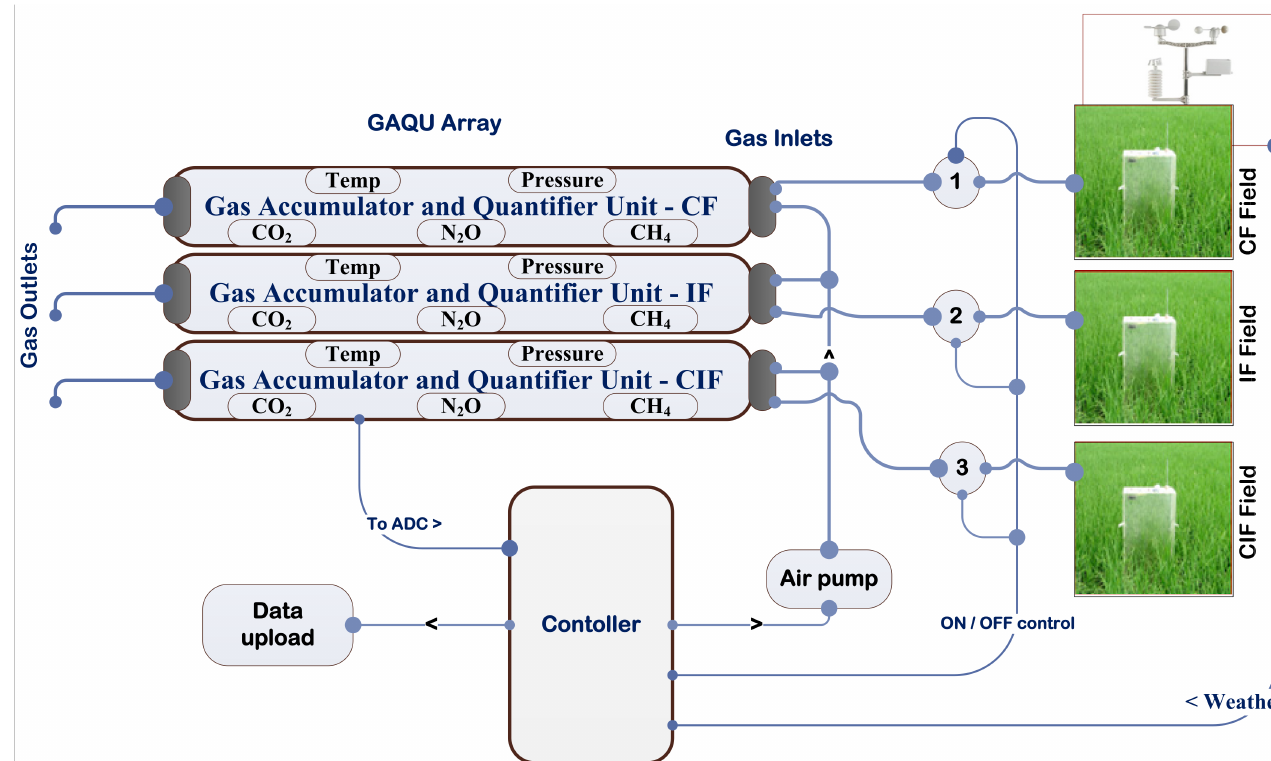
Figure 3. Automated sensor assisted gas sampling and estimation system.